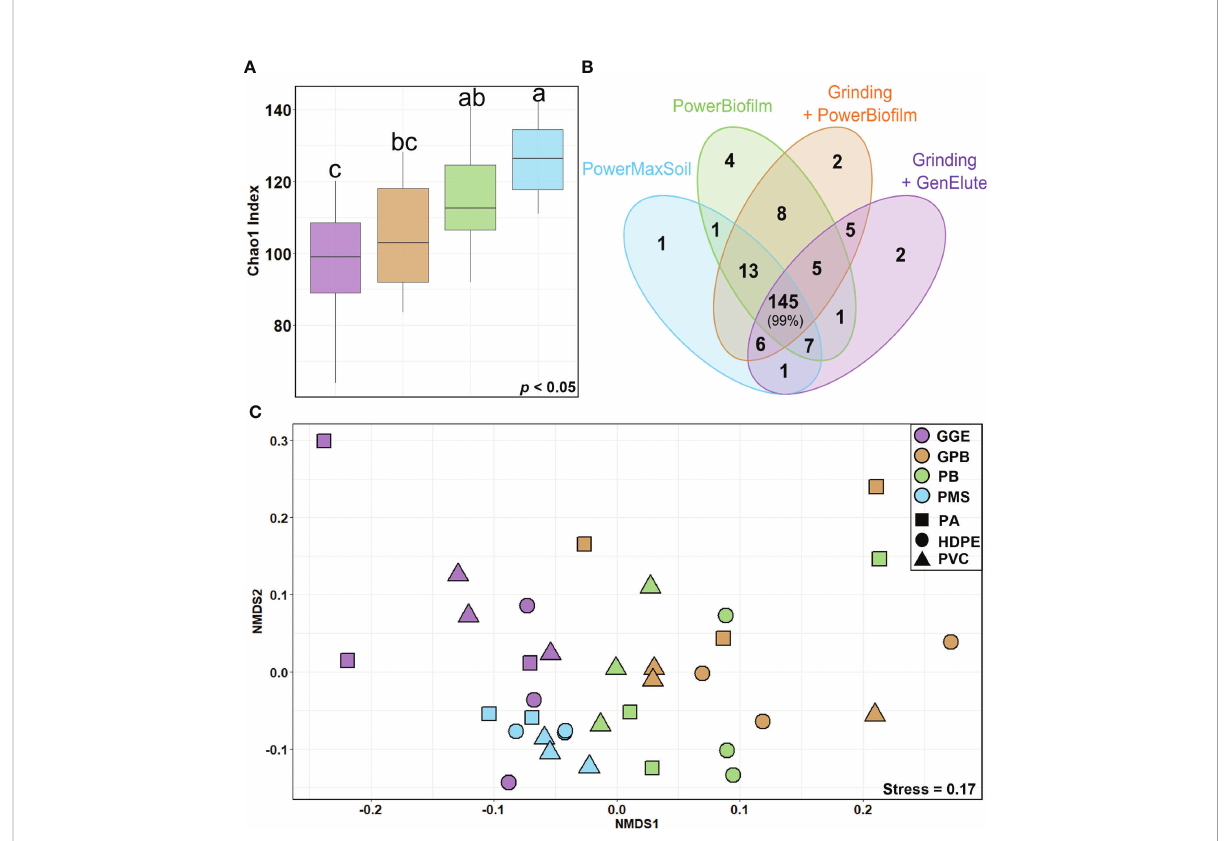
FIGURE 1 Diversity of eukaryotic communities according to different DNA extraction methods (A) Boxplots of the Chao1 index at the genus level for each extraction method. The line in each box plot indicates the median, the box delimits the 25 th and 75 th percentile, and the whisker is the range. Letters above boxplots represent pairwise comparisons between each method. (B) Venn diagram of genera identi fi ed for each extraction method. Numbers within overlapping ellipses show numbers of genera shared between methods; numbers in non-overlapping ellipses show unique genera for the method; percentage indicates the associated proportion of reads. (C) NMDS of the eukaryote community composition across different surfaces (shapes) and determined with different extraction methods (colors). Unweighted unifrac distance was used for matrix distance. Each point represents one sample. PowerBio fi lm (BF), PowerMaxSoil (PMS), Grinding step followed by PowerBio fi lm (GBF) Grinding step followed by the GenElute bacterial genomic (GGE), Polyamide (PA), High Density Polyethylene (HDPE), polyvinyl chloride